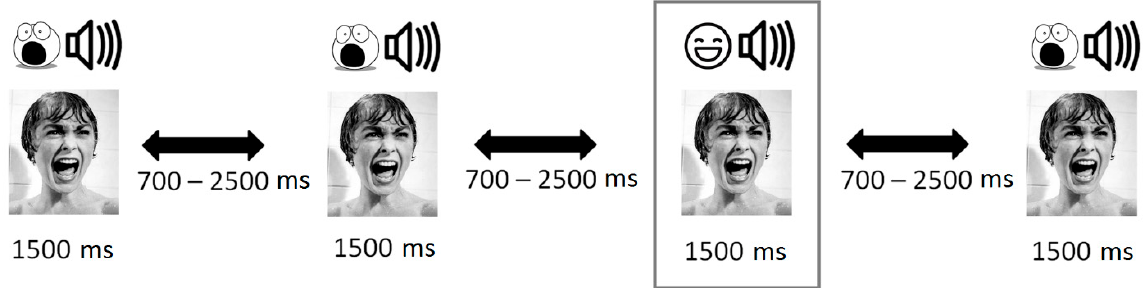
Figure 1. Visualization (pictures from Internet resources) of used multimodal odd-ball paradigm experimental design.